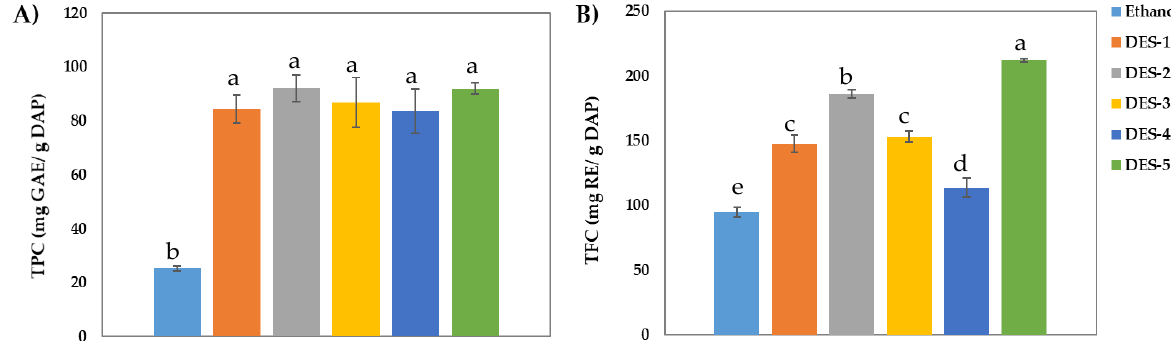
Figure 1. ( A ) Total phenolic content (TPC) and ( B ) total flavonoid content (TFC) obtained for the avocado peel extractions carried out with DES and ethanol. Data are means ± standard deviation ( n = 3). Different letters indicate a statistical difference ( p < 0.05).